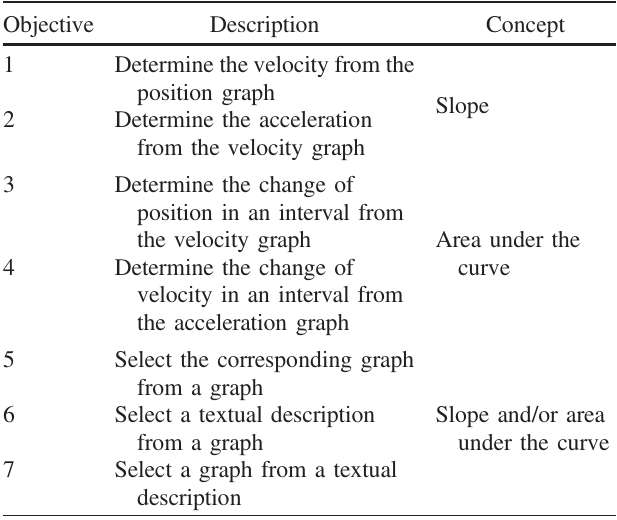
TABLE I. Objectives and concepts evaluated in the original version of the test. Note that all the graphs are graphed with respect to